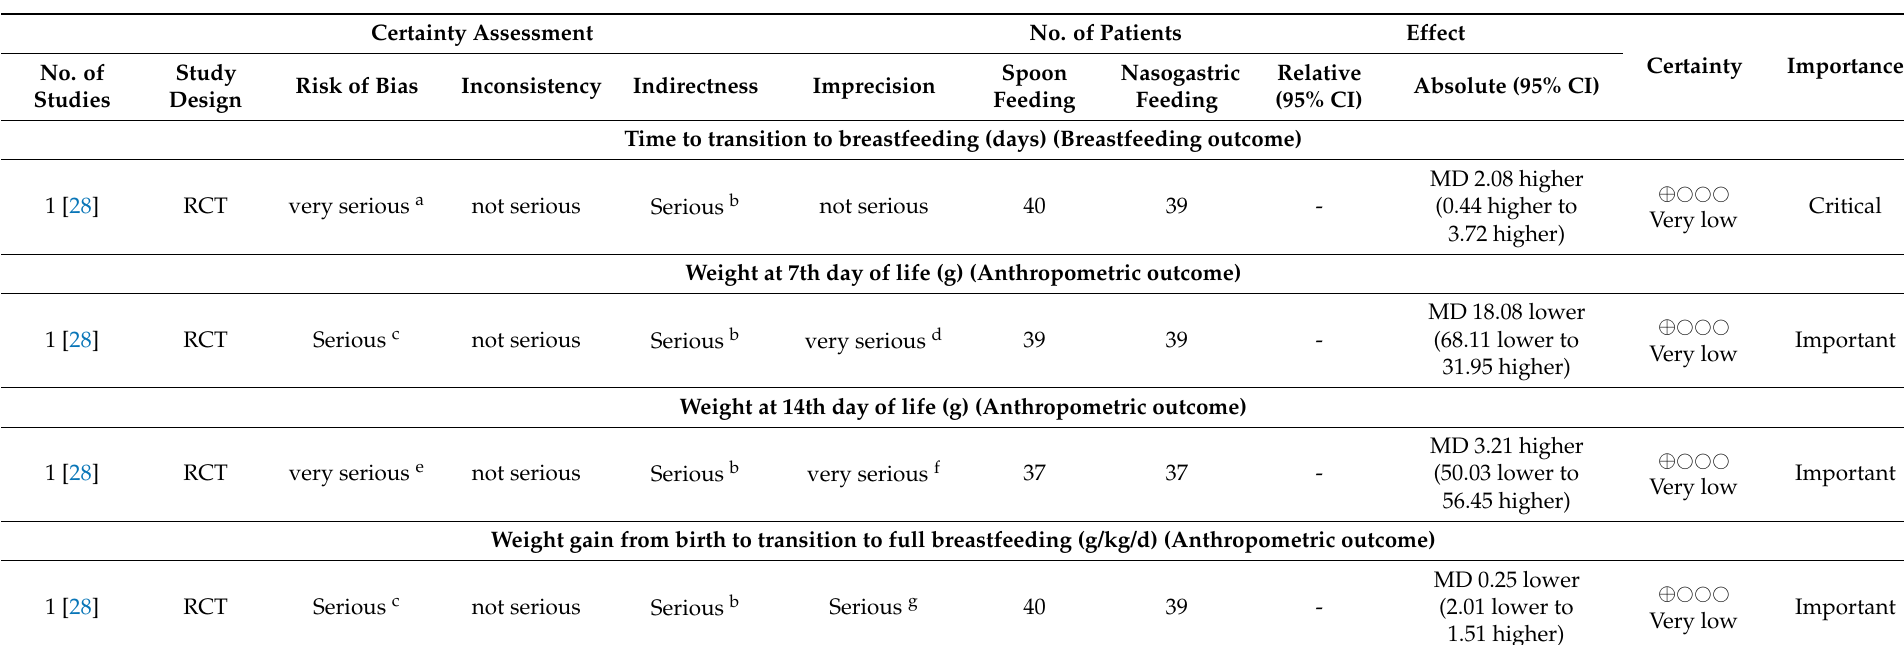
Table 5. GRADE evidence profile: Spoon feeding compared to nasogastric feeding for infants u6m with growth faltering. Certainty Assessment No. of Patients Effect